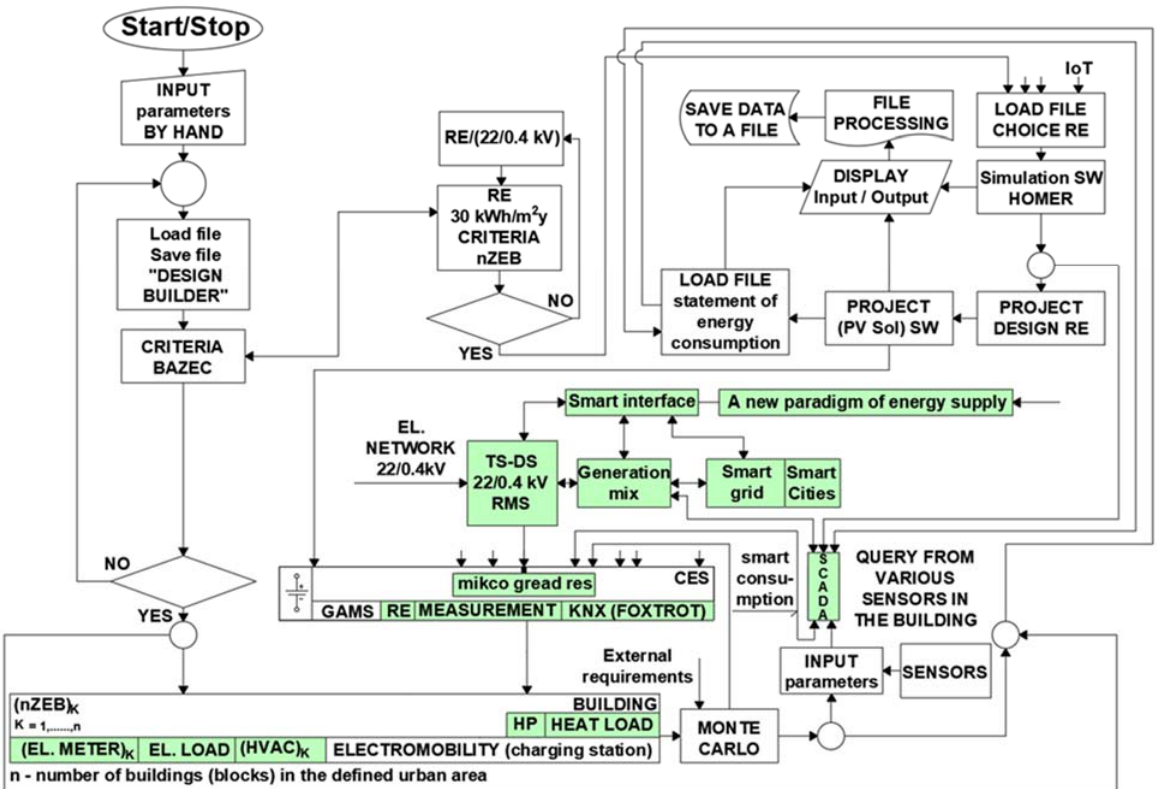
Figure 2. Energy model of a building in the environment of energy performance of buildings and smart Grid.